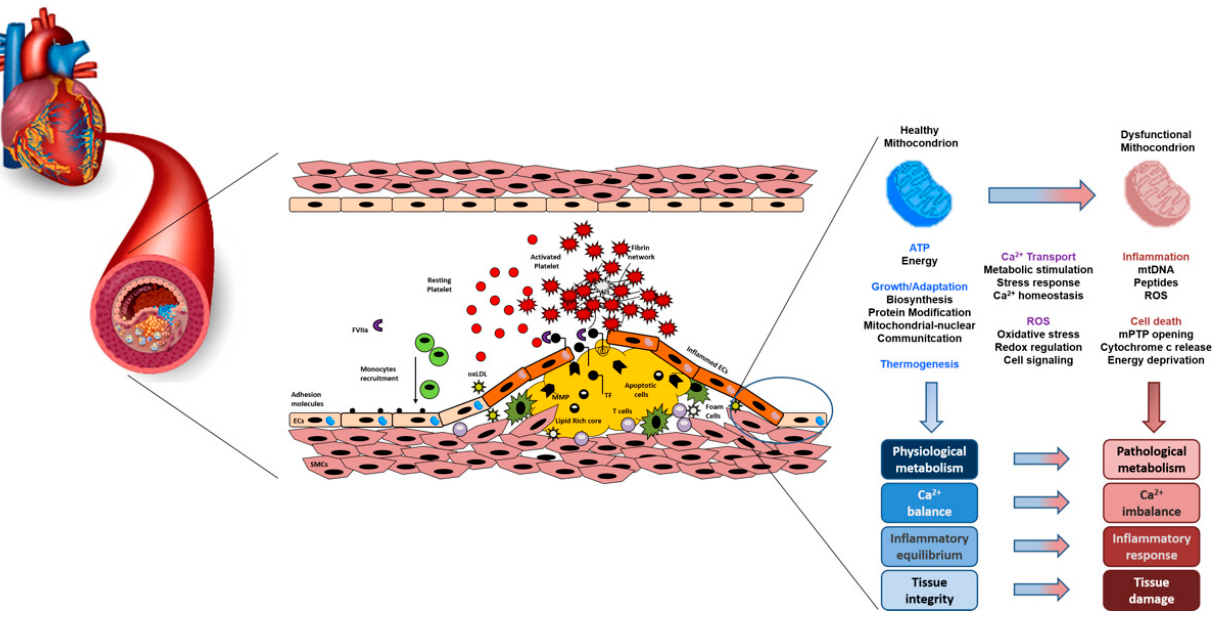
Figure 1. A schematic view of the interaction between mitochondria dysfunction, atherosclerosis and oxidative stress.